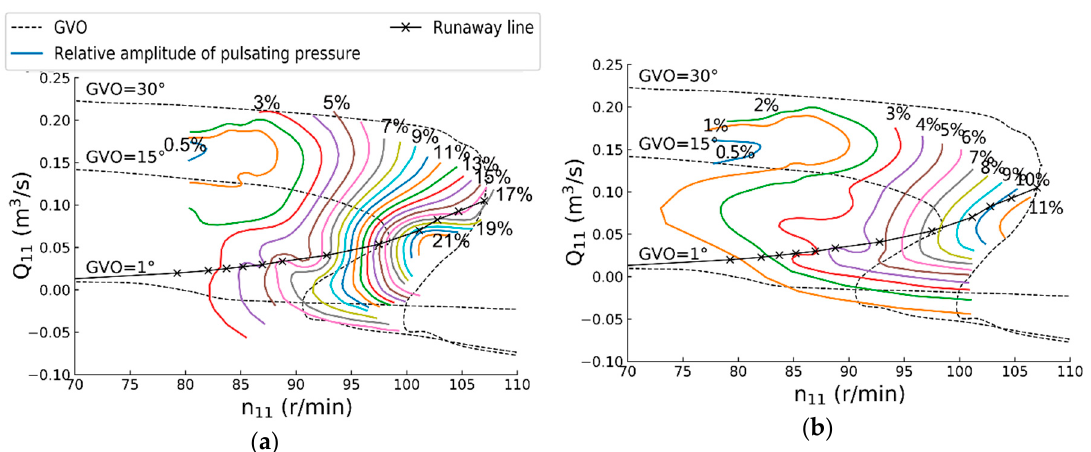
Figure 5. Extended peak-to-peak diagrams of the pulsating pressures in a model pump turbine at ( a ) the spiral case and ( b ) the draft tube.